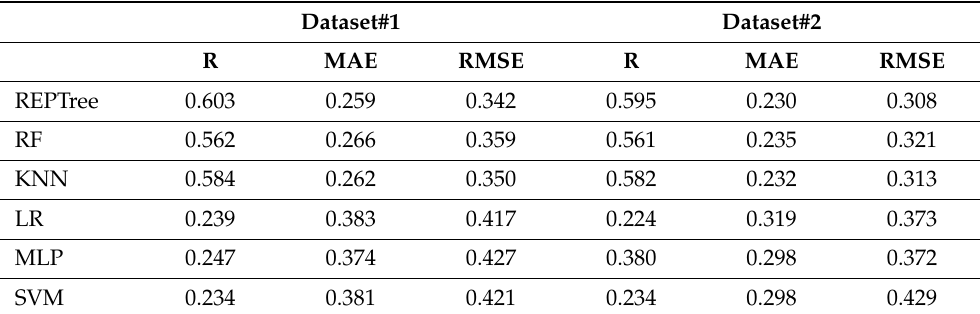
Table 5. Regression analysis results for the LCC metric.